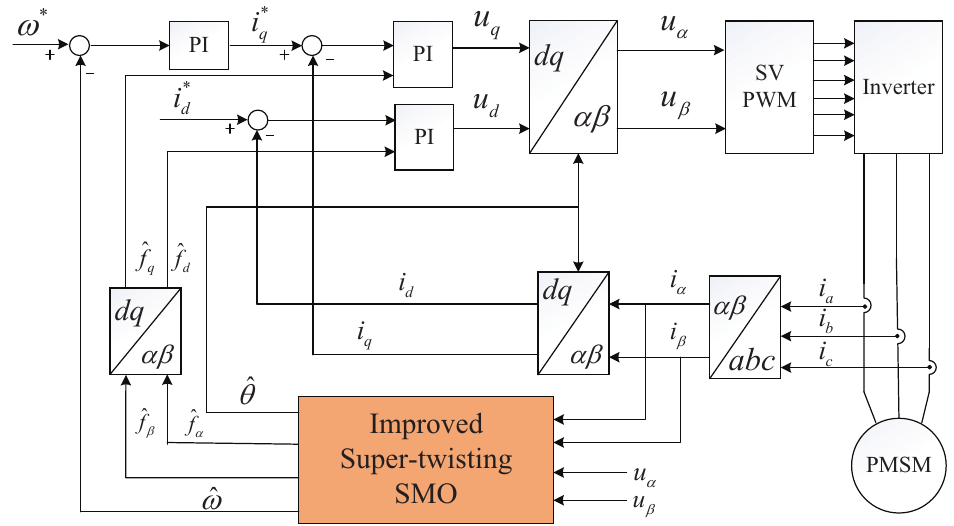
Figure 1. Block diagram of the sensorless control system of PMSM.